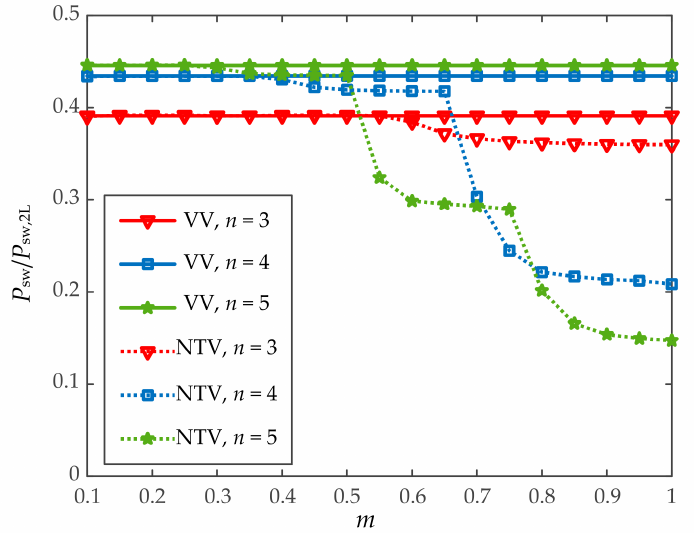
Figure 13. Switching power loss in a three-phase multilevel NPC DC–AC converter operated with the VVPWM and operated with a reference NTV PWM in per unit value of the switching power loss of a two-level converter